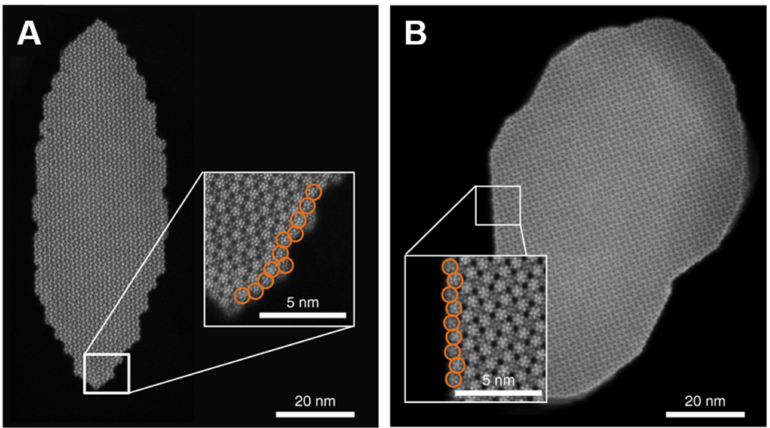
Figure 18. ADF-STEM images of the (001) plane of M1 MoVTeNbOx particles. ( A ) Sample prepared by the new synthesis method, after drying overnight in air at 80 ◦ C, and ( B ) sample prepared by the previous method, followed by crystallization at 650 ◦ C in inert. Insets show representative lateral surface termination. Circles highlight complete pentagonal M 6 O 21 units observed near the termination. Adapted from ref. [84], Copyright (2019), with permission from Springer